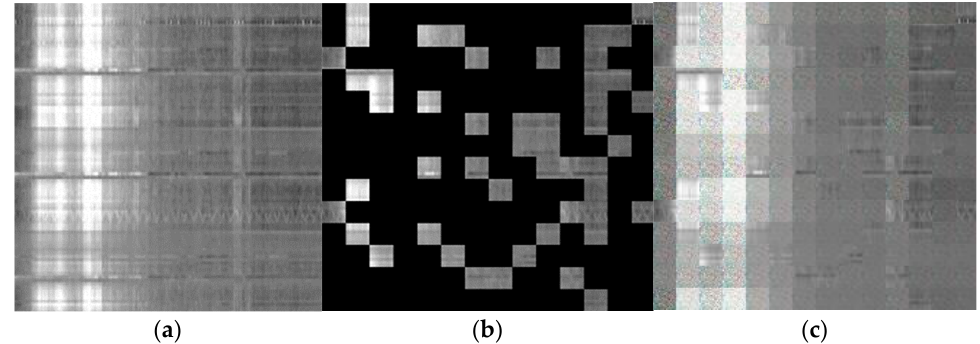
Figure 6. BERT masking experiments. ( a ) Original image; ( b ) after 75% masking; ( c ) restored images.